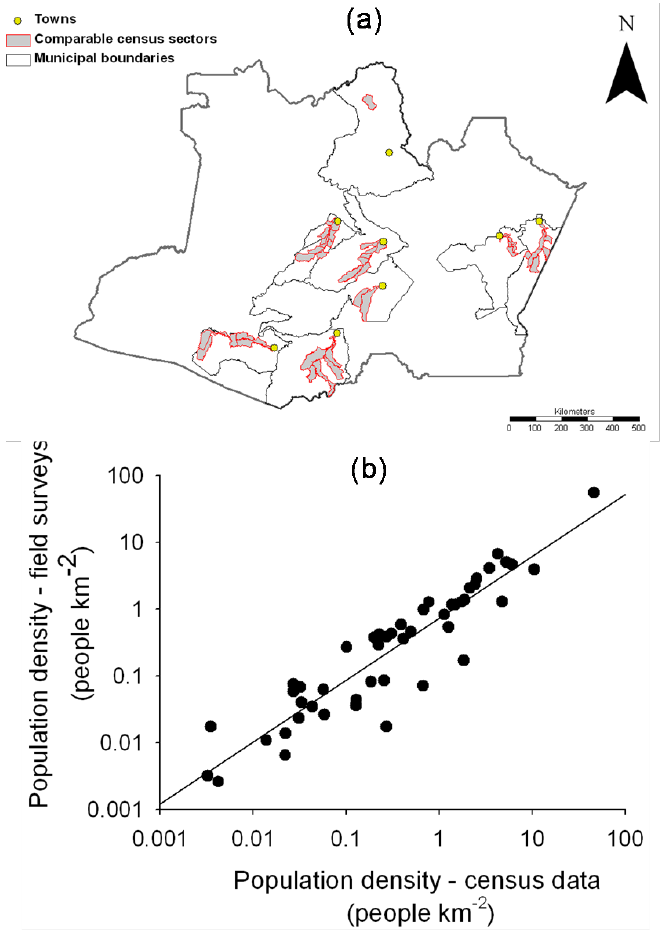
Figure A2. (A) Map of Amazonas state, Brazil, showing census sectors for which we compared governmental 2007 census data and our own surveys, based on field observations, interviews, and local and state health databases. Note this also includes population data from the R. Maués (far right), collected during a pilot study. (B) Comparison of 2007 population density estimates from the national census of the Brazilian Institute of Geography and Statistics (IBGE) and our field surveys. Pearson correlation (log(POPibge+1) ~ log(POPfield+1))= 0.983, n = 52, p <